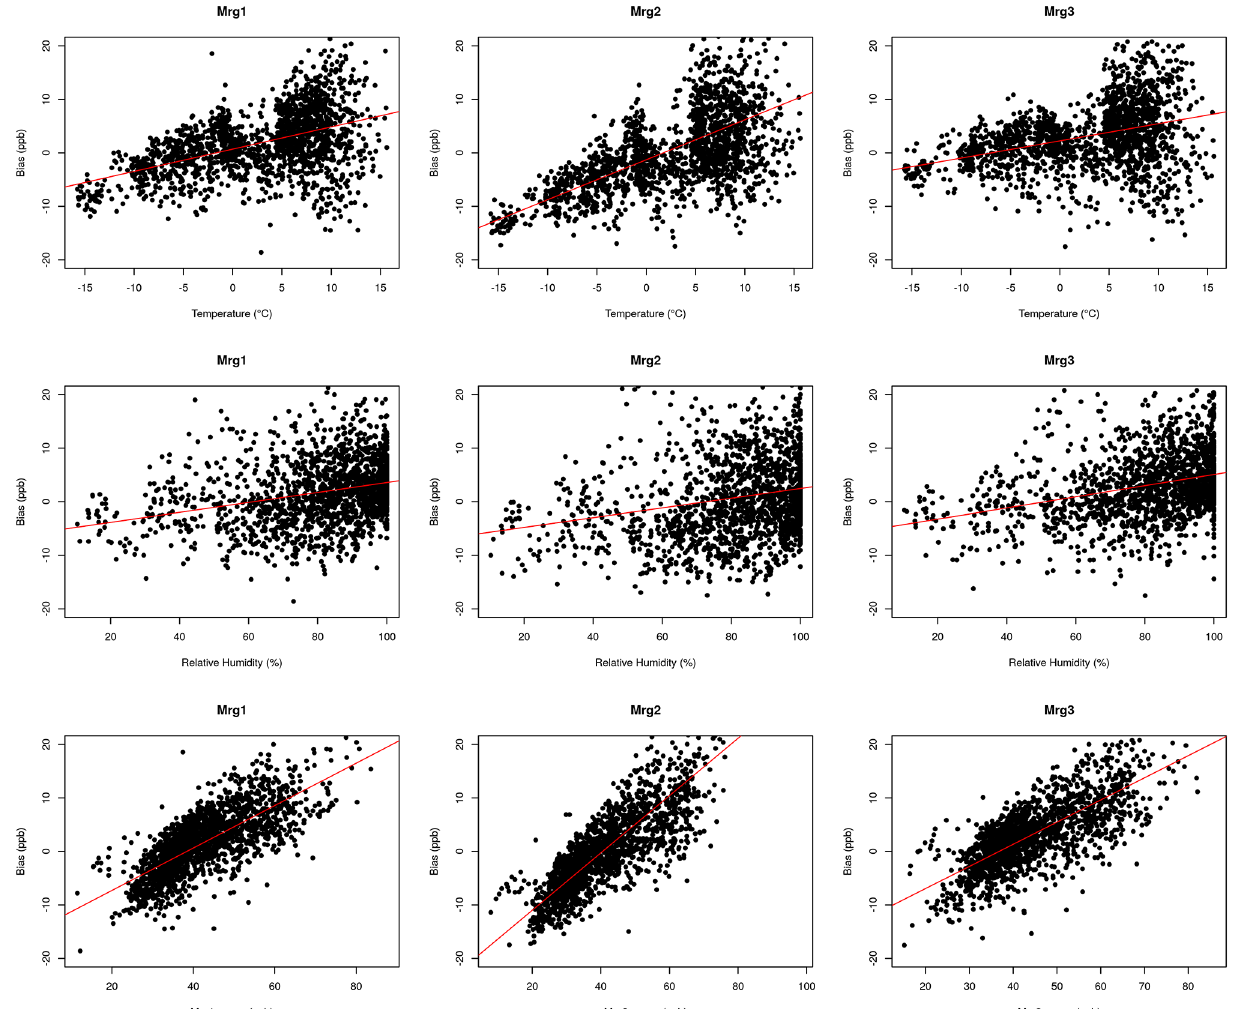
Figure 5. The environmental variables with a non-negligible linear correlation with the LCS